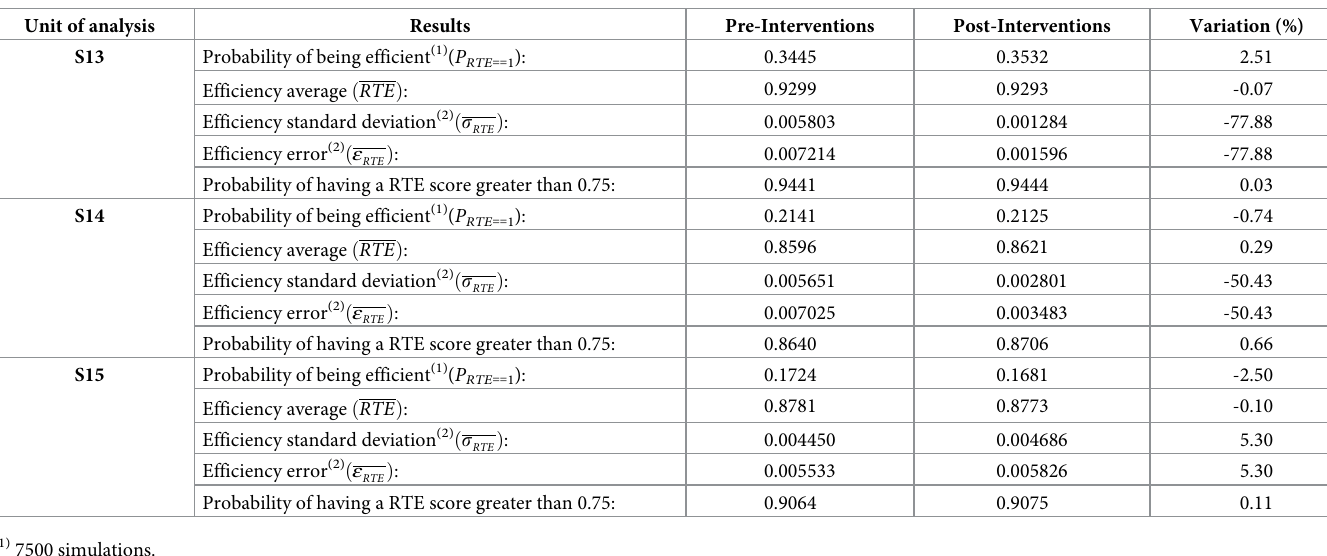
According to the input management, the entropy of the global system is very high, 3.83 (85.82% up to the feasible maximum). In the output management analysis, it is also high, 3.21 (72.01% up to the feasible maximum). These results indicate that the Bizkaia MH system can be easily improved by selecting appropriate interventions (Table 5, “pre” column). Fifteen Scenarios (pre-management interventions). From an input management perspec- tive, the greatest stab = 24.08 corresponds to (S4) delivery of day care health related, while the lowest stab = 5.87 is for (S15) combination of placement capacity and workforce capacity for residential, day and outpatient care. In contrast, output management (S8) placement capacity health related care has the highest stab = 23.61, while (S6) outpatient care has the low- est stab = 12.50 (Table 5, “pre” column).